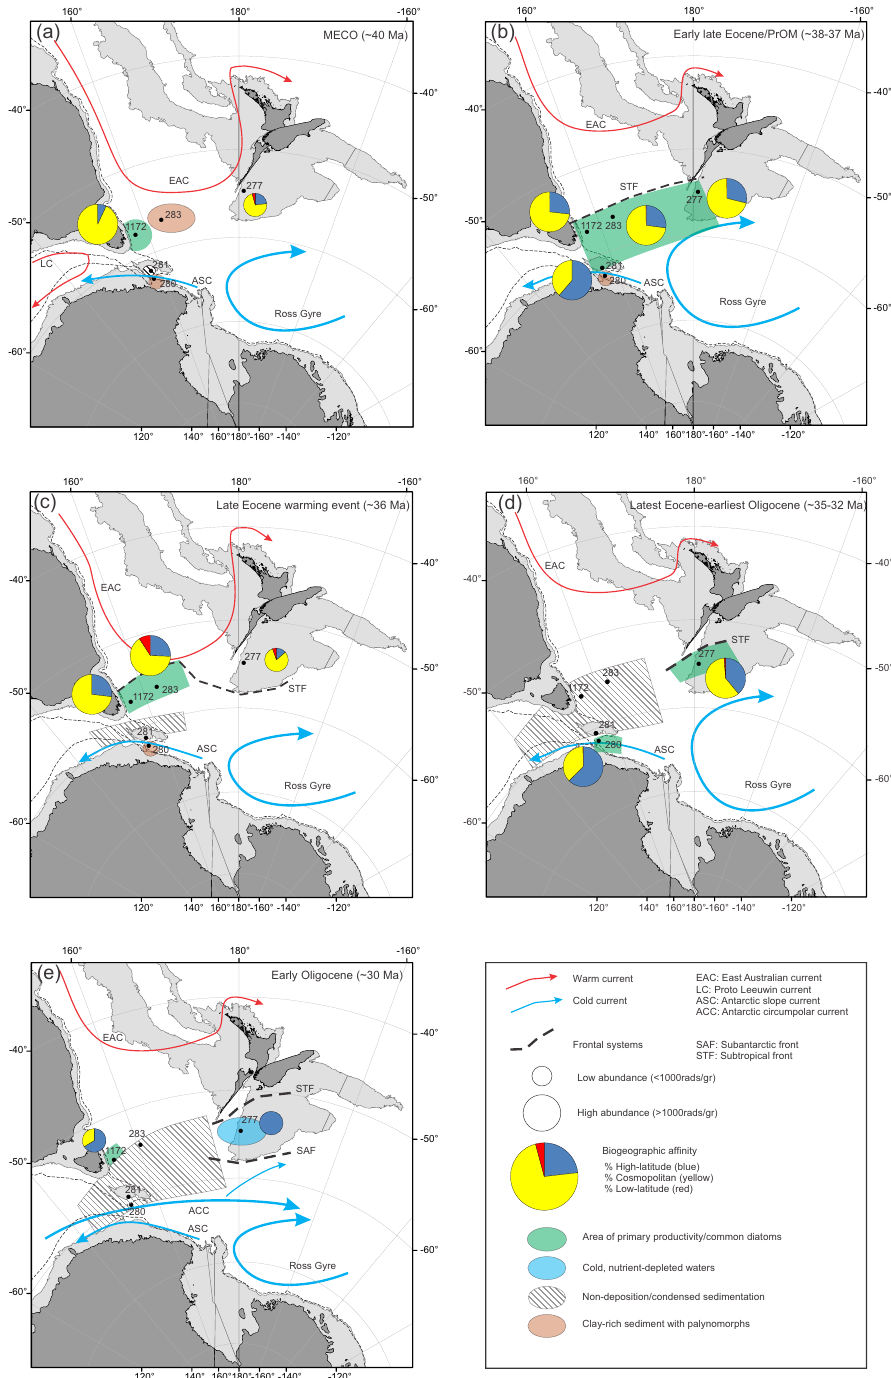
Figure 8. Palaeogeographic reconstructions and biogeographic affinities at investigated sites during the MECO ( ∼ 40Ma), early late Eocene/PrOM ( ∼ 38–37Ma), late Eocene warming event ( ∼ 36Ma), latest Eocene–earliest Oligocene ( ∼ 35–32Ma), and early Oligocene ( ∼ 30Ma). The 2000m isobath from the GEBCO (www.gebco.net) bathymetric grid was used to approximate continental boundaries (light grey). The continental–oceanic boundaries of Bird (2003) are also shown for reference (dashed lines); continents with present-day shorelines are in dark grey. The late Eocene average is plotted for Site 1172 in map (b) and (c)